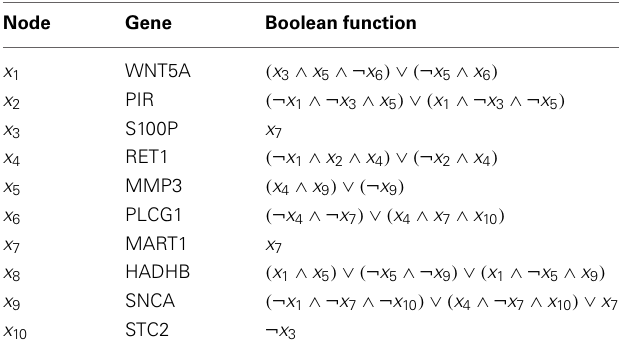
Table 2 | Regulatory functions in the metastatic melanoma network [Modified from Table 1 in Yousefi and Dougherty